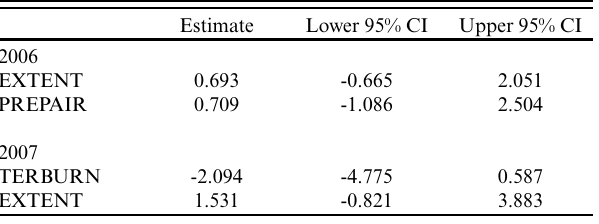
Table 2 . Model-averaged parameter estimates from top models for predicting reproductive status of Bachman’s Sparrows ( Peucaea aestivalis ) following the application of breeding-season prescribed fire. EXTENT distinguishes males associated with large-extent (70 - 100 ha burn blocks) or small-extent (< 15 ha) burn treatments. TERBURN (territory burned) distinguishes males that occupied home ranges where most (≥ 75%) ground cover was removed by fires versus males that occupied home ranges where most ground cover was not removed by fires (at least 75% retained). PREPAIR males were those individuals that were paired or showed other evidence of breeding prior to burns.